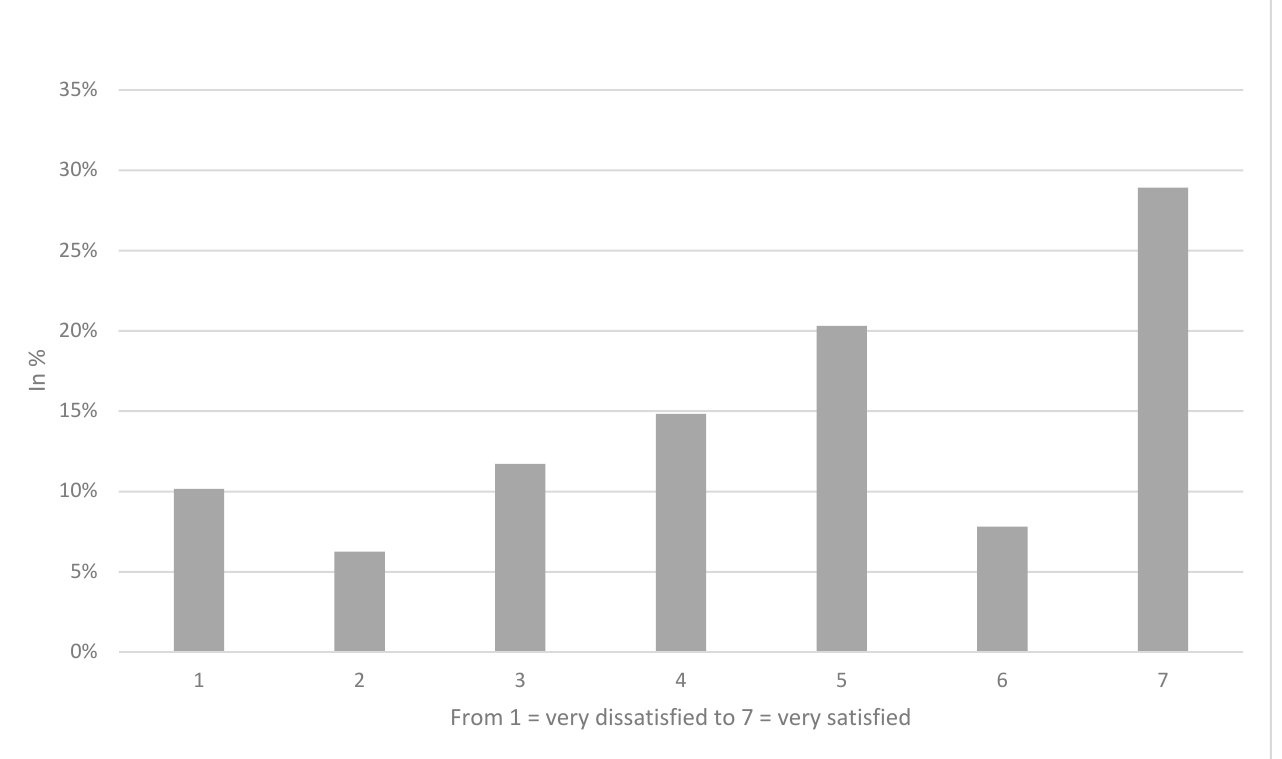
Figure 1. Satisfaction with the corresponding telemedicine services. Table 1. Sample characteristics ( n = 967).